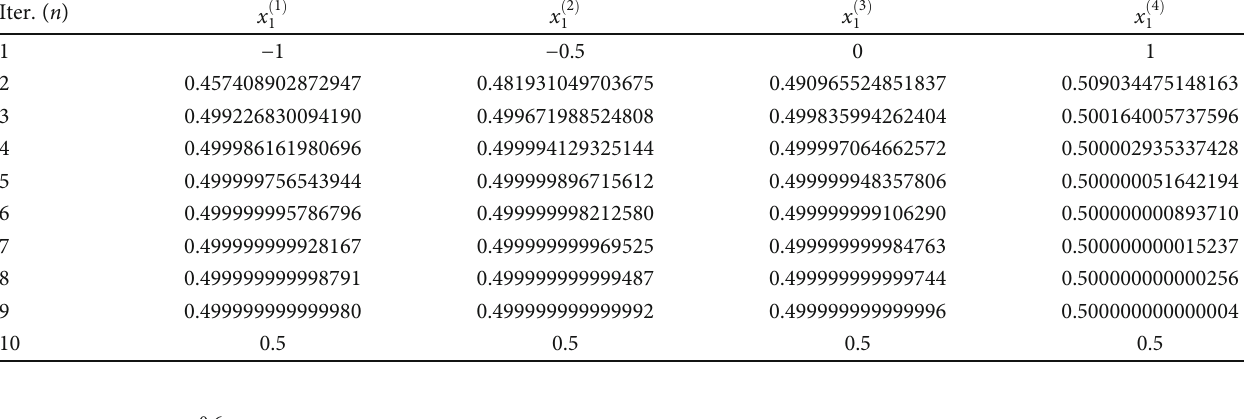
Table 1: In fl uence of initial points.